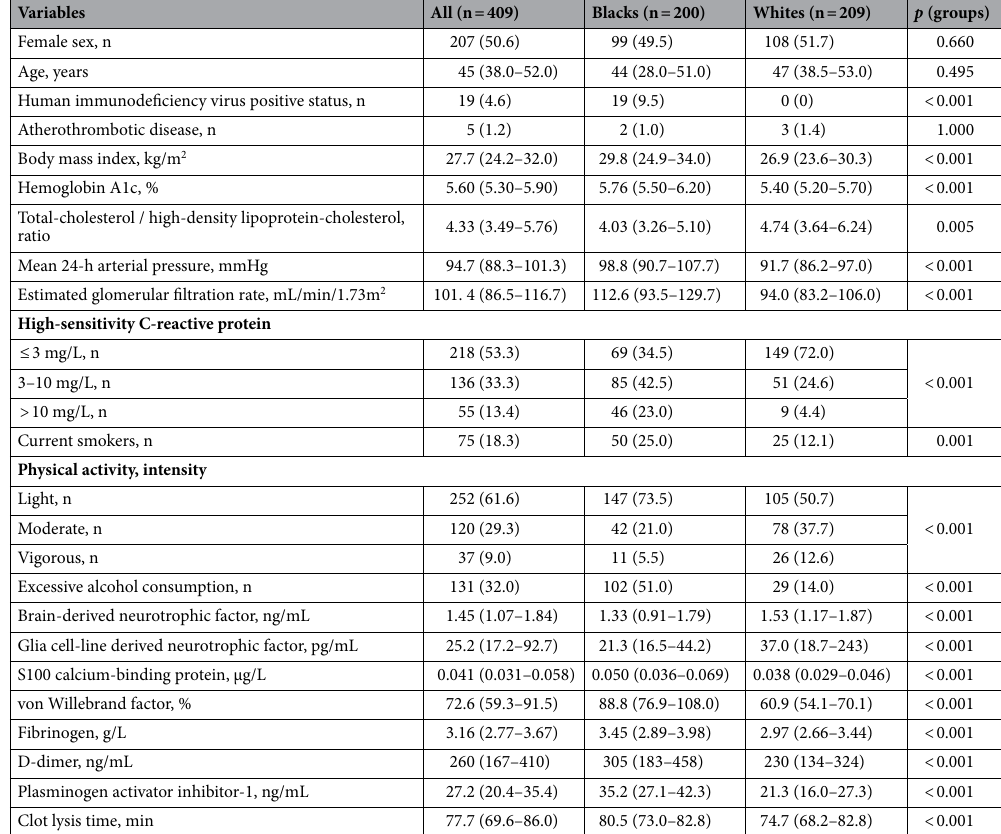
Table 1. Characteristics of all study participants and compared between black and white South Africans. Values are percentages or median with inter-quartile